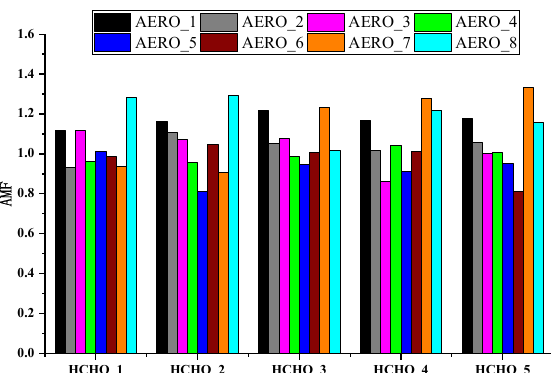
Figure 9. AMF values corresponding to the combination of the HCHO profile and AEC clusters. The colours correspond to the AEC profiles in Figure 7 for each cluster. The change in the x-axis corresponds to the HCHO profiles in Figure 6a for N HCHO = 5.